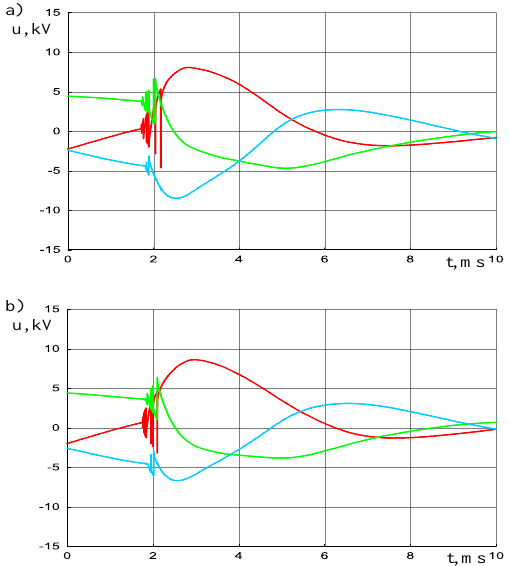
Figure 4. Transient overvoltage waveforms at transformer terminals Tr (Figure 3) switched o ff with a vacuum circuit breaker wb connected to the transformer by a 85 m long cable line lc: ( a )—system with surge arresters, ( b )—system without surge